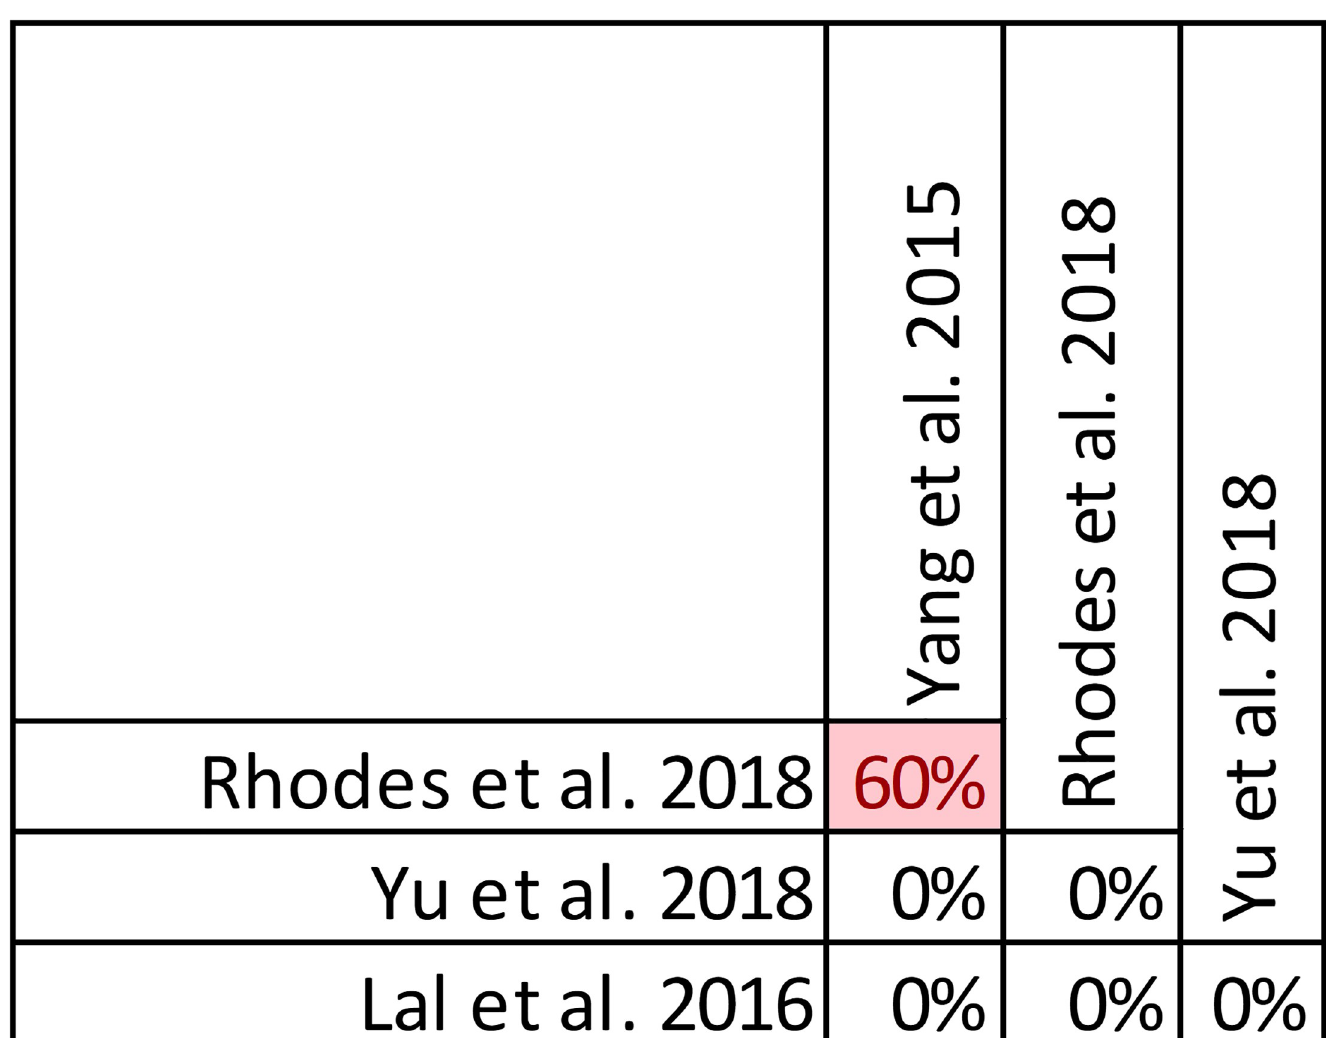
Fig 11. Pairwise CCA for reviews reporting microbiologic cure of prolonged versus intermittent beta-lactam infusions. Colors indicate degree of overlap, as calculated with CCA, for visual clarity. White = � 5%, green 5.1–9.9%, yellow 10–14.9%, red � 15%.